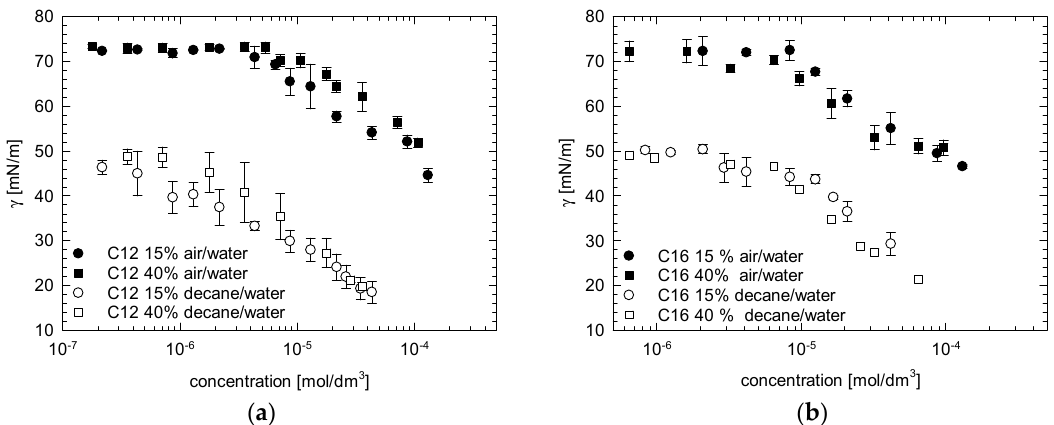
Figure 3 . The dependence of the surface tension at air/solution and interfacial tension at the decane/solution interface on